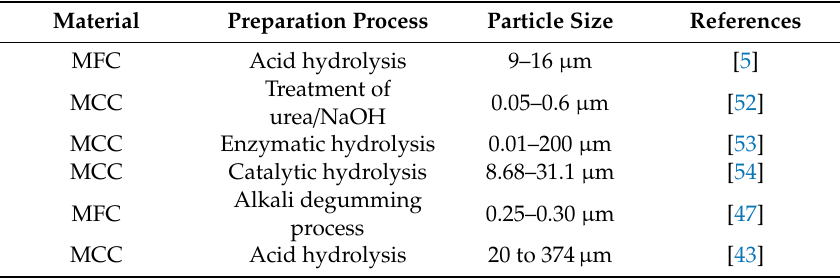
Figure 2. Scanning electron microscope (SEM) images of di ff erent forms of microcellulose materials. ( a , b ) Surface of micro-fibrillated cellulose from the bleached cotton stalk [49], ( c , d ) the surface of micro-microcrystalline cellulose from the cotton stalk [50], ( e , f ) microcellulose particles of cotton, adapted [51]. Table 2. Material and process of microcellulose